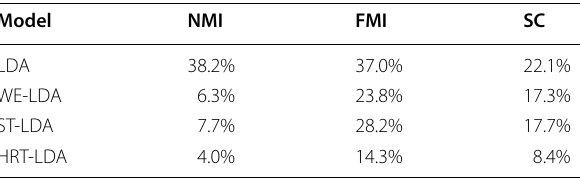
clusters are incorporated to semi-supervise the LDA training process, which can elicit better dis- tributed representations of Web services.